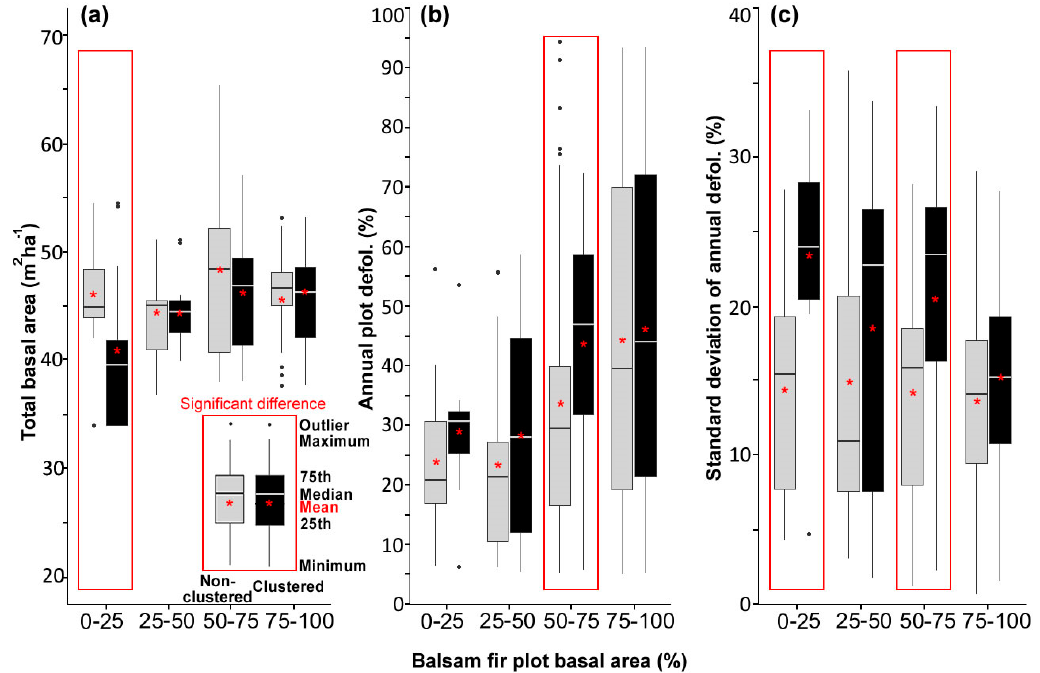
Figure 1. Comparison of plots with and without significant clustering of defoliation (based on results of global Moran’s I analyses ( α = 0.05) for all host trees) by 25% balsam fir plot basal area classes for ( a ) total basal area in the plot, ( b ) average current year defoliation, and ( c ) standard deviation of individual tree defoliation within plots.